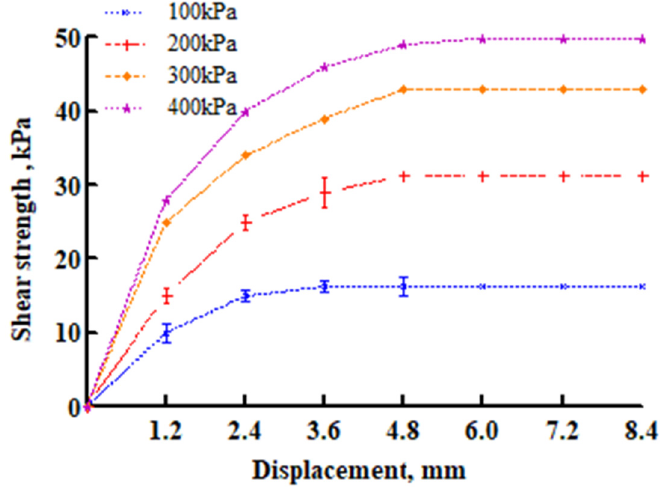
Figure 8. The relationship between shear strength and displacement under different vertical loadings.